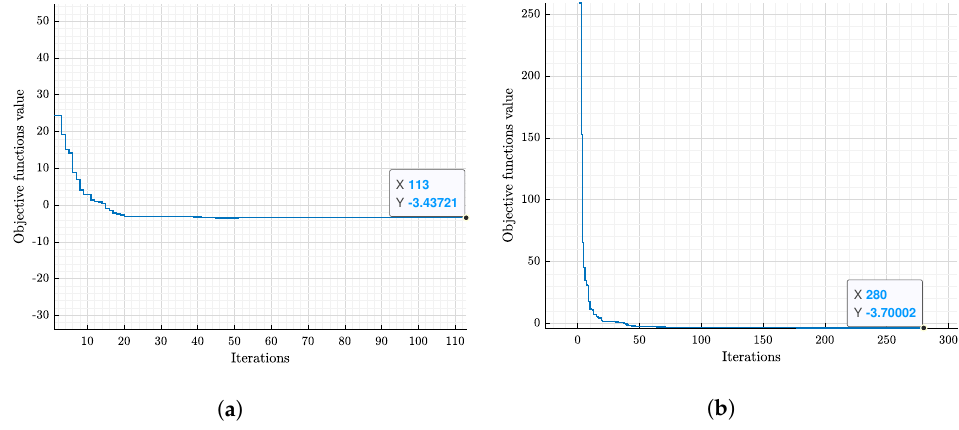
Figure 9. ( a ) The fitness curve for the BFGS algorithm when searching for the optimum of the generated problem when d = 6, N = 15. ( b ) The fitness curve for the BFGS algorithm when searching for the optimum of the generated problem when d = 11, N =